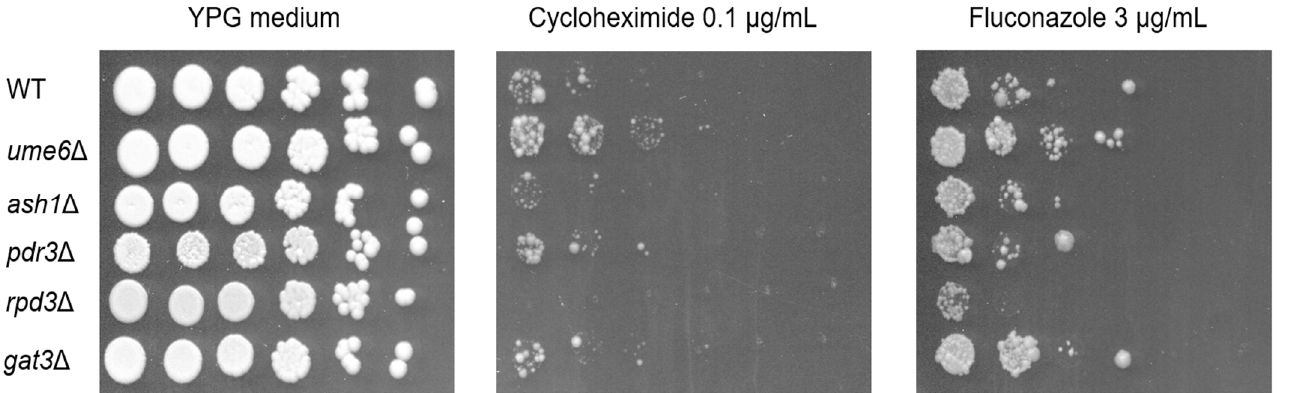
Figure 1. The ρ + cells of the ume6 ∆ mutant are more tolerant to fluconazole and cycloheximide than those of the wild type on YPG plates. Fluconazole and cycloheximide resistance of ρ + cells of the wild-type strain (FY1679-28C) and its derivative strains, ume6 ∆ ꞉꞉ bleMX6 , ash1 ∆ ꞉꞉ bleMX6 , pdr3 ∆ ꞉꞉ bleMX6 , and rpd3 ∆ ꞉꞉ bleMX6 , and gat3 ∆ ꞉꞉ bleMX6 , were determined by spot dilution assay in YPG plates with or without 3 μ g/mL fluconazole (or 0.1 μ g/mL cycloheximide).